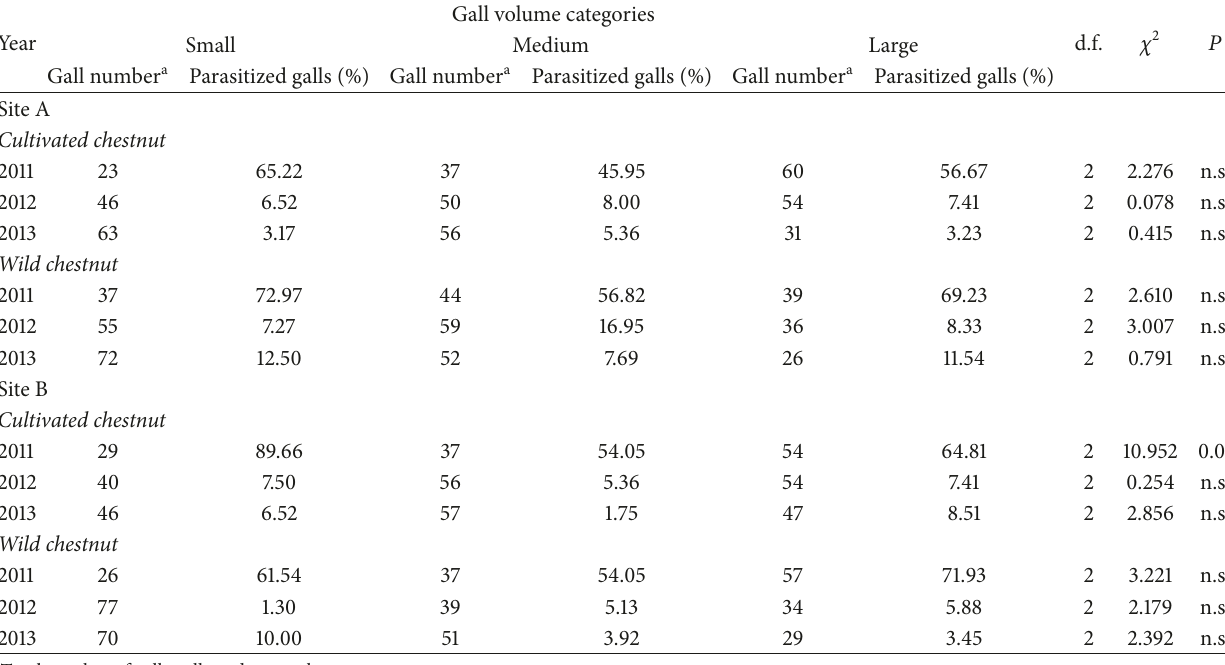
Table 2: Galls of Dryocosmus kuriphilus, collected from cultivated and wild chestnuts in the two study sites (site A = 478 m a.s.l.; site B = 665 m a.s.l.) at Marradi (Italy), sorted by volume categories (small = 0.02–0.064 cm 3 ; medium = 0.065–1.31cm 3 ; large = 1.32–15.48 cm 3 ). Nonsignificant 𝑃 values are indicated by n.s.